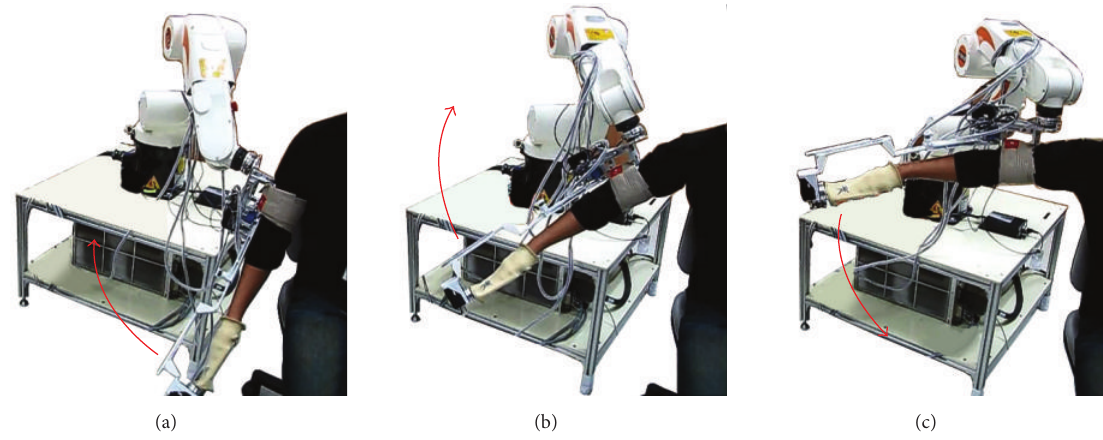
Figure 10: Example movements of SEFRE Rehab System: shoulder